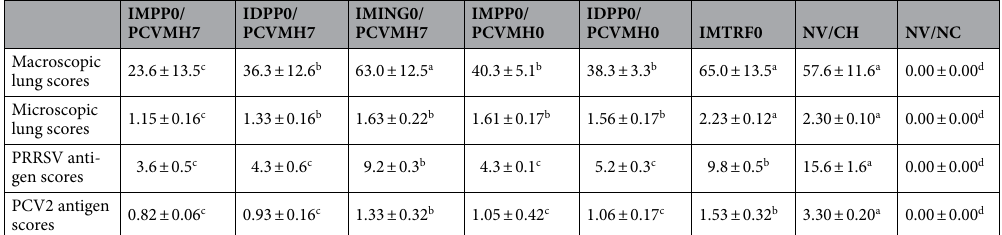
Table 2. The mean values of macroscopic-, microscopic lung scores, and antigen scores in tissues at 7 DPC. Values expressed as mean ± SEM. The results were compared using two-way ANOVA for multiple comparisons. Different lowercase letters (a–d) indicate significant differences between treatment groups ( p < 0.05) for each